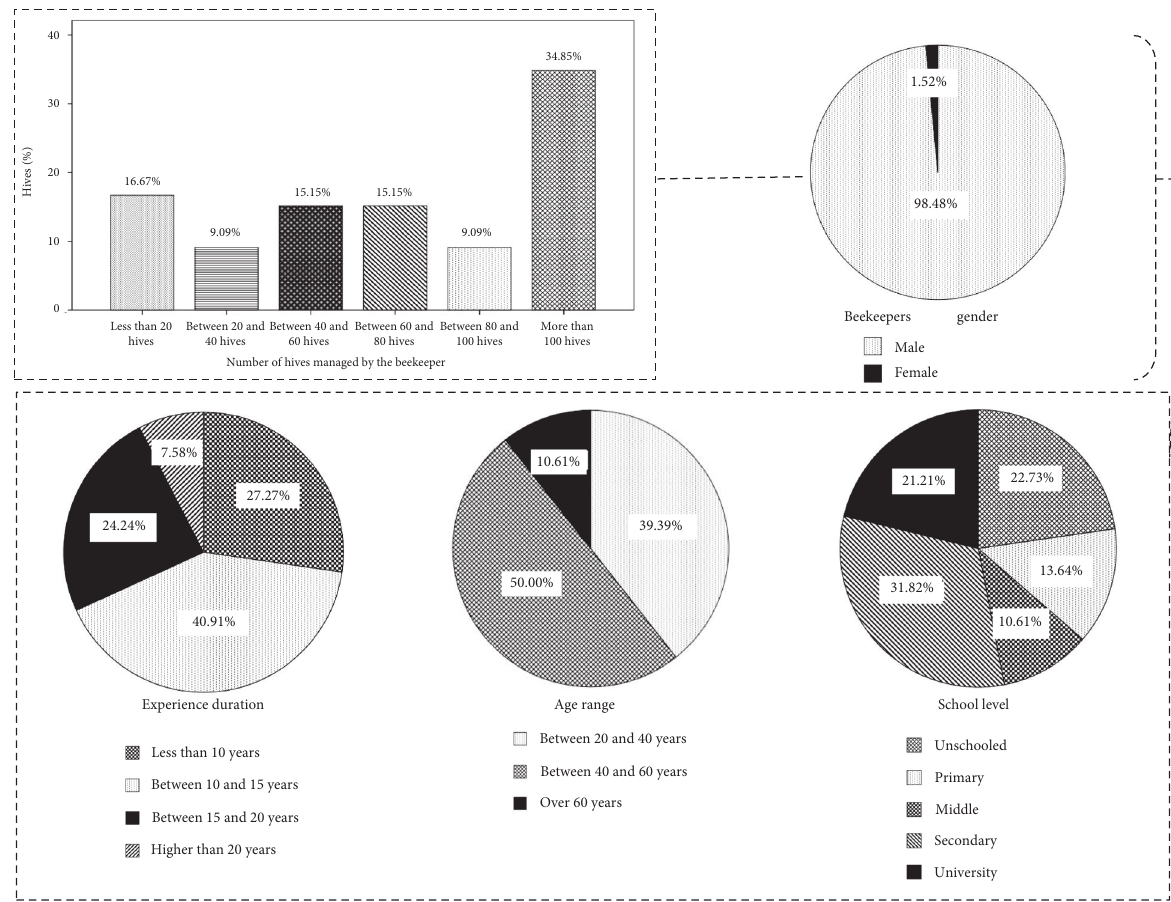
Figure 2: General information on beekeepers and their